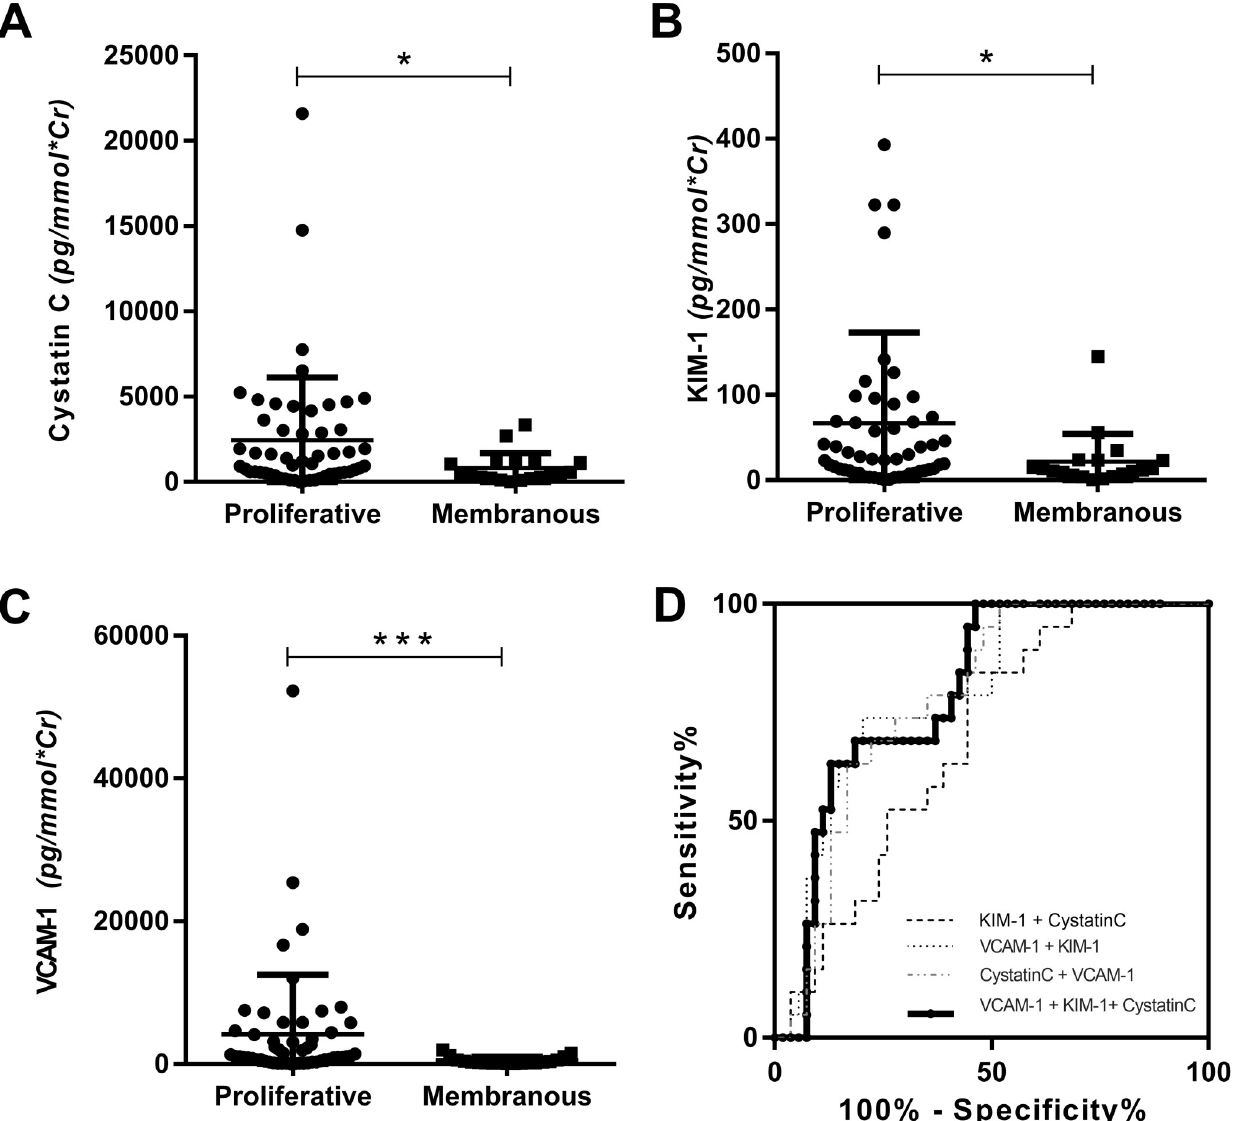
Fig 2. Comparison of three urinary markers in different pathologic classes of lupus nephritis. Comparison of uCystatinC (A), uKIM-1(B), and uVCAM-1(C) levels in proliferative and membranous LN patients and ROC curve for the combined two and three UBMs to differentiate proliferative LN from membranous LN (D). KIM-1: kidney injury molecule 1, VCAM-1: vascular cell adhesion molecule 1, Sen: sensitivity, Spe: specificity, PPV: positive predictive value, NPV: negative predictive value, AUC: area under the curve.